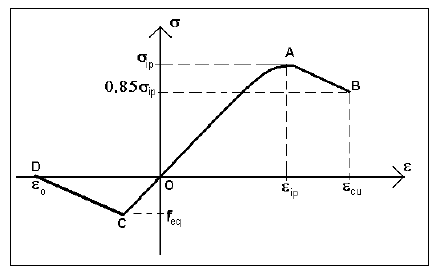
Figure 1. Stress strain curve for the concrete.